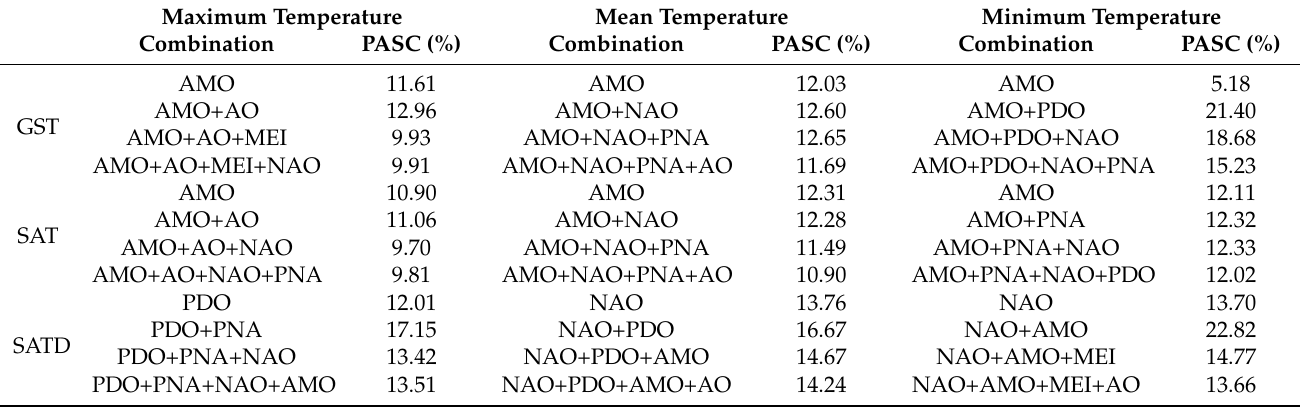
Table 10. Percentage area of significant coherence (PASC) in multi-wavelet transform coherence between the anomaly of the monthly averaged GST-, SAT-, and SATD-related indexes and large-scale indexes from 1980 to 2019 in Southwest